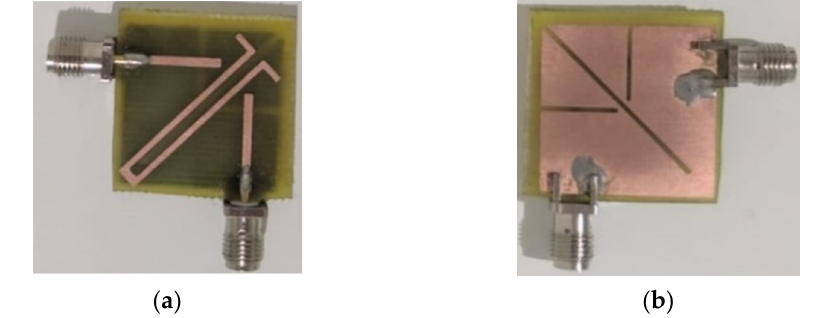
Figure 8. Proposed MIMO antenna prototype: ( a ) top view and ( b ) bottom view.